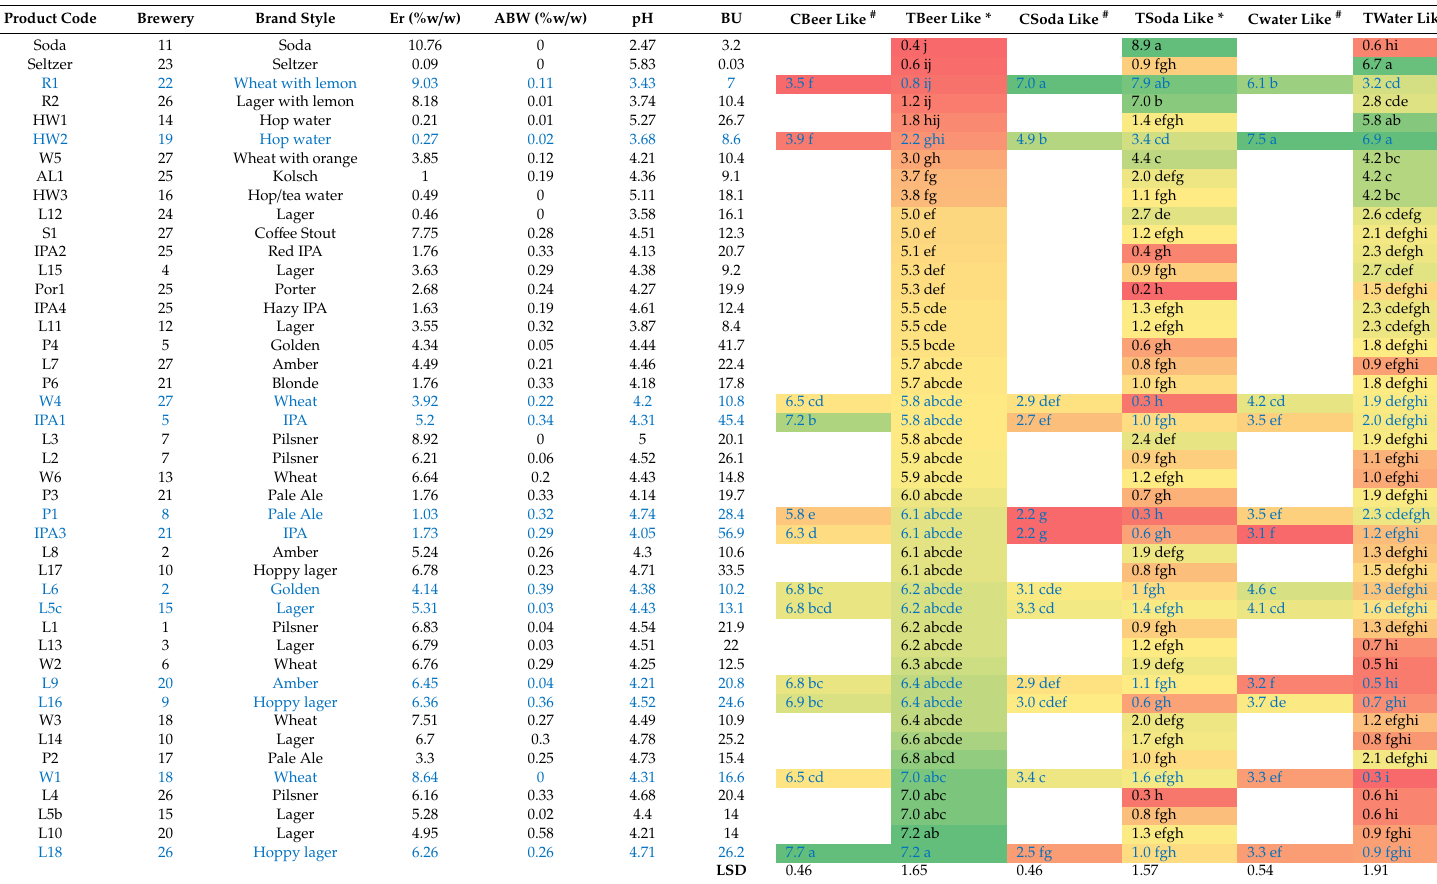
Table 1. Non-alcoholic beer, soda, and seltzer basic non-volatile quality specifications as well as how similar the consumer panel and trained panel rated the products to beer, soda, and water.